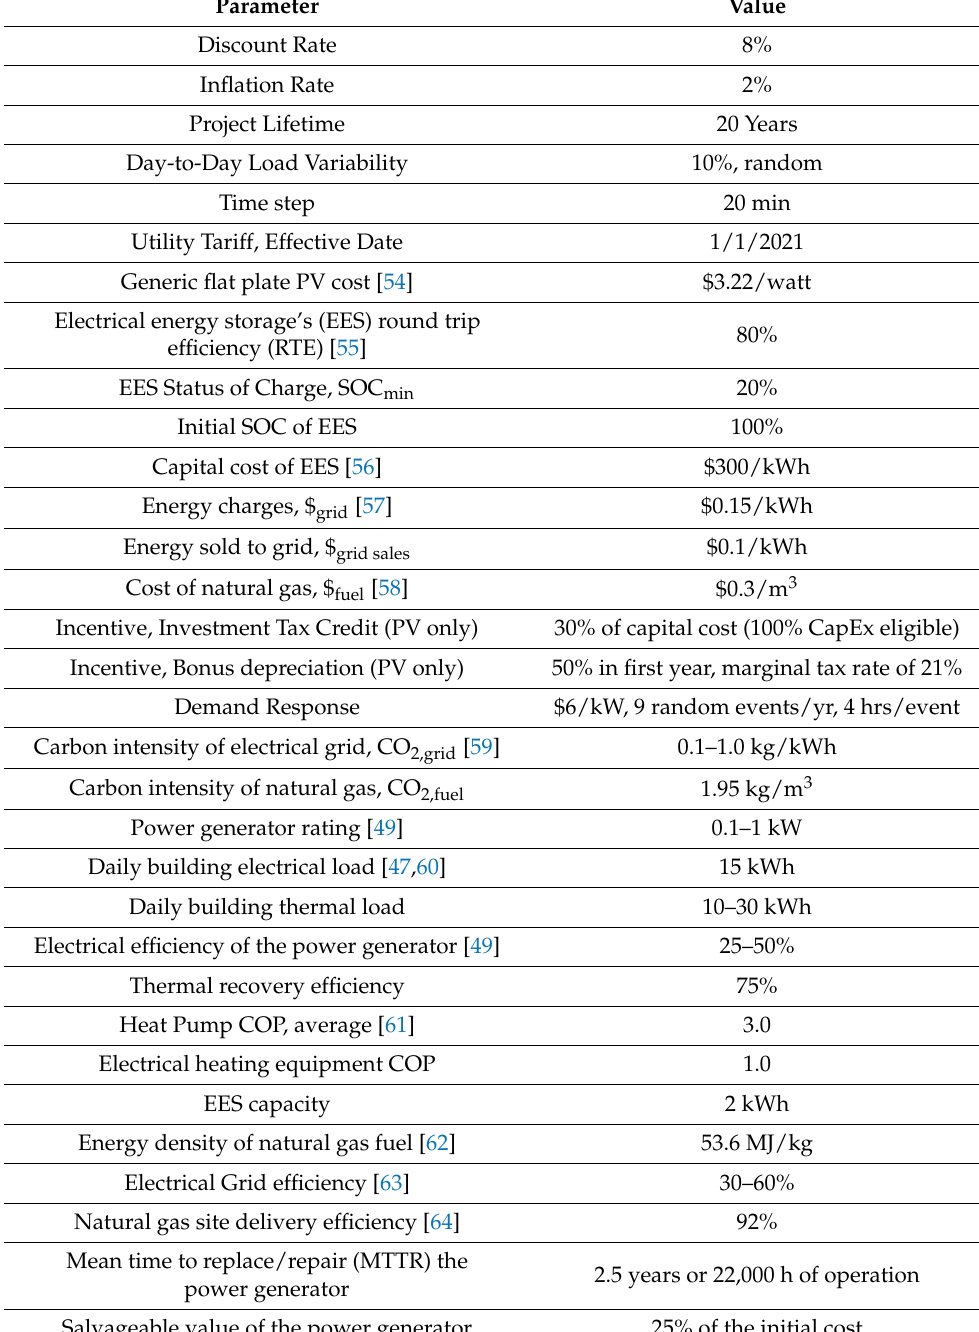
Table 2. Performance and cost modeling